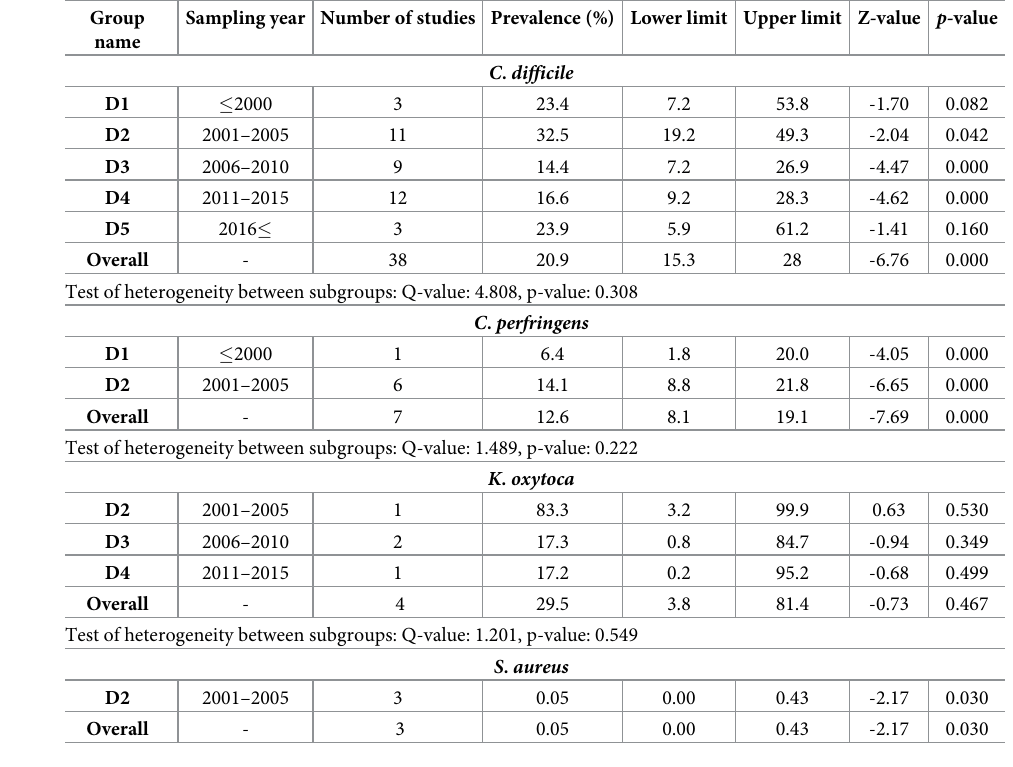
Table 2. Subgroup analysis of bacterial prevalence in AAD patients based on the sampling